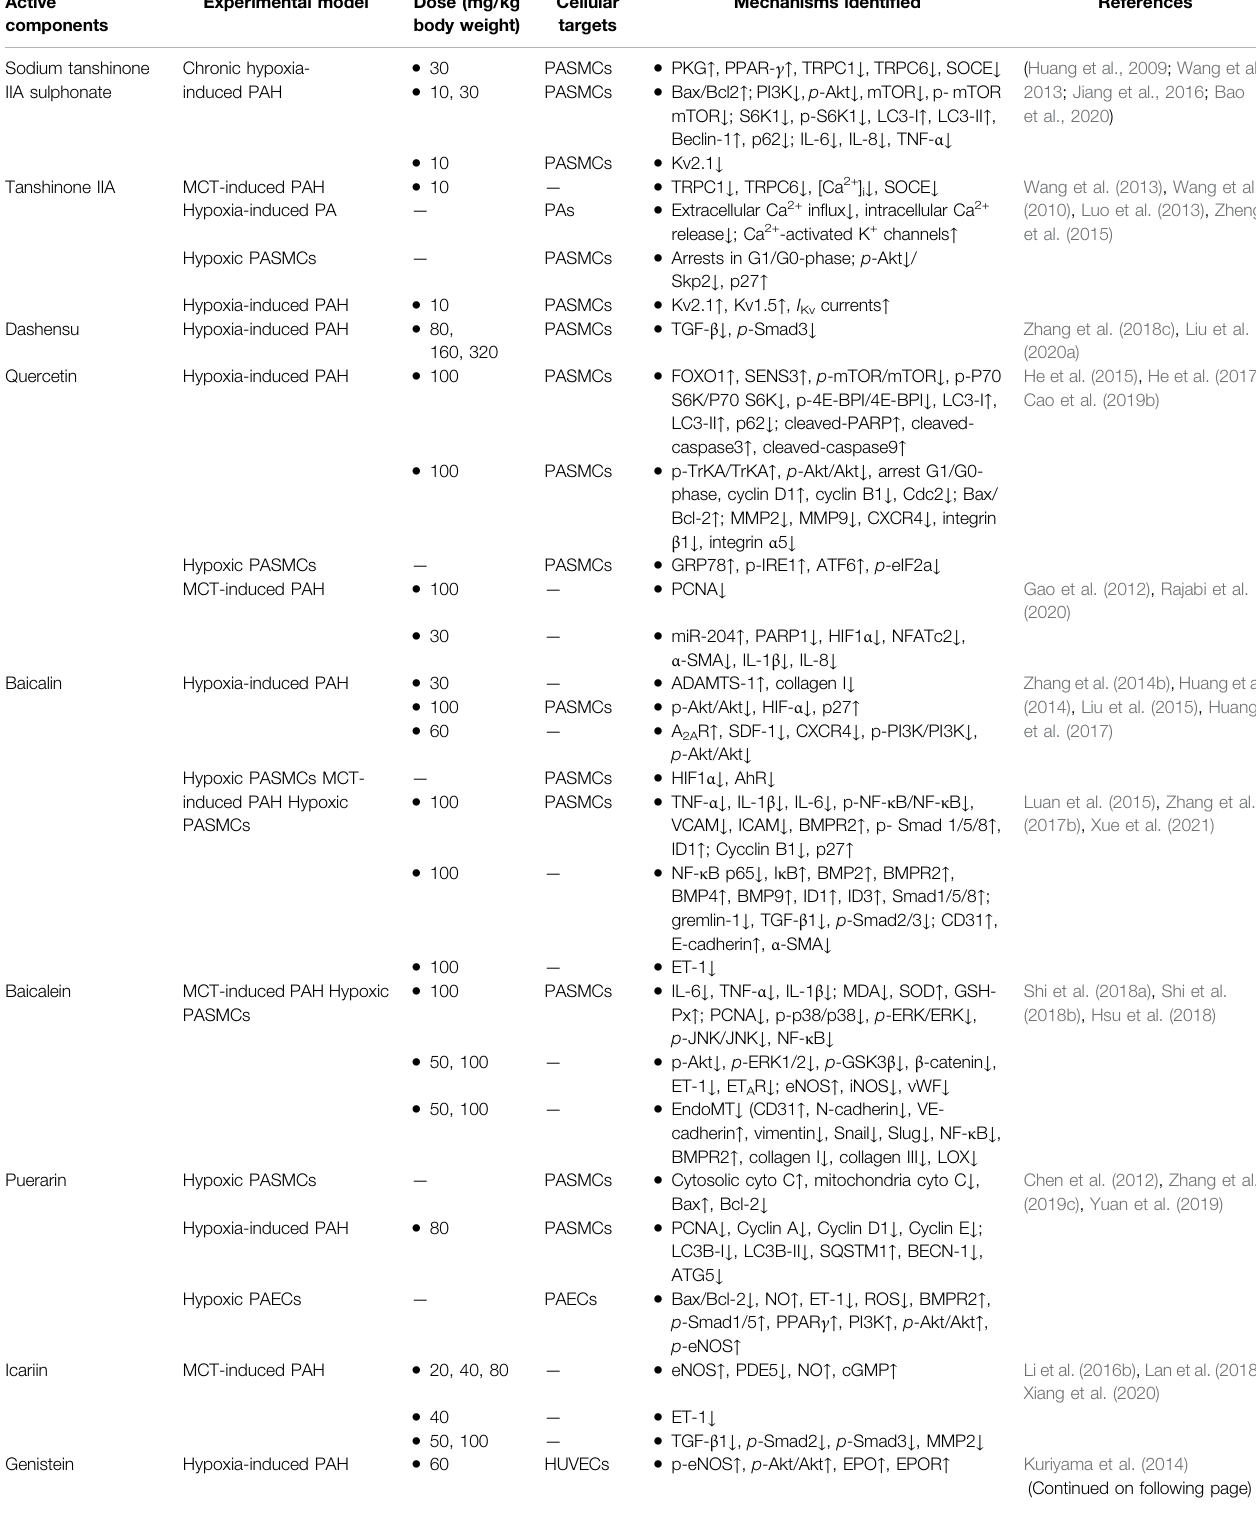
TABLE 3 | Flavonoids as THM-derived active components for PAH